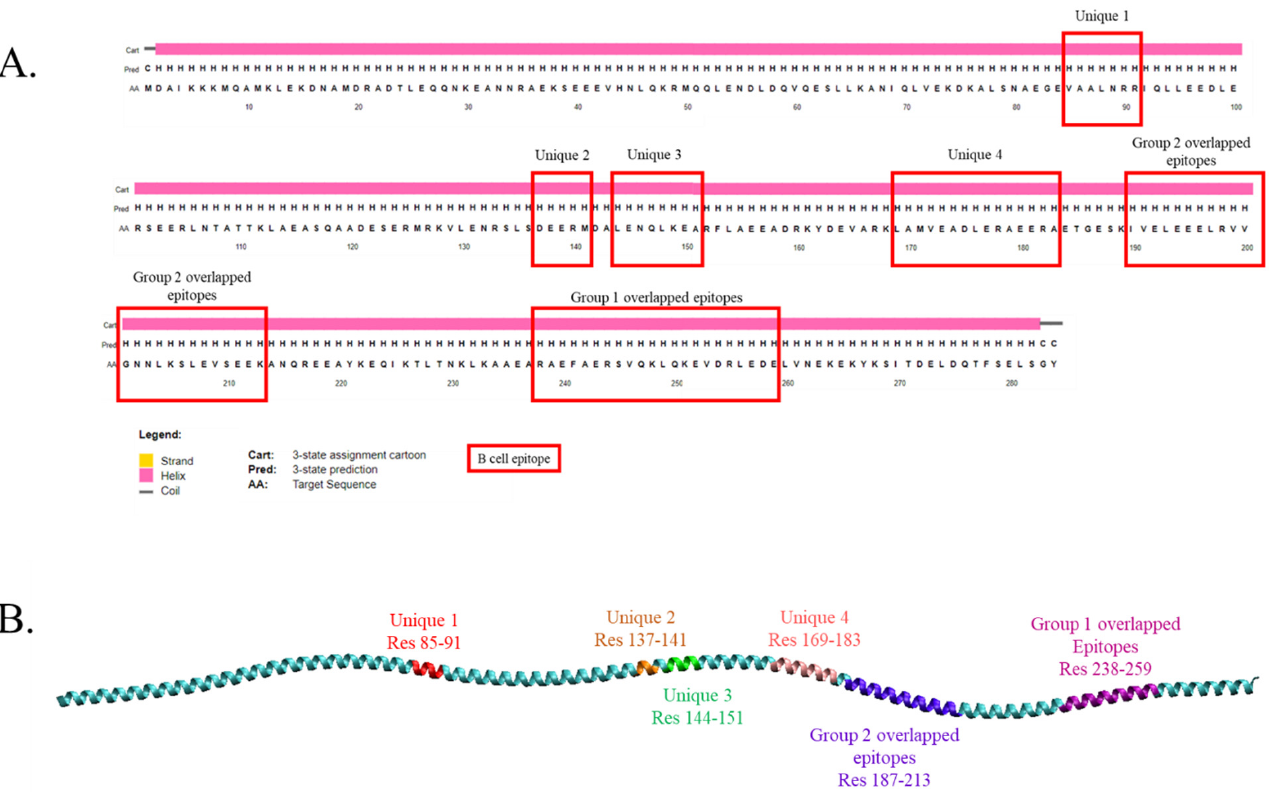
Figure 2. Consensus linear B cell epitope identified by AlgPRED and BepiPRED web tools. ( A ) Sequence with the predicted secondary structure of black tiger shrimp tropomyosin. The predicted consensus amino acids responsible for cross-reactive allergy were indicated in the red square. ( B ) The location of each type of identified linear B cell epitopes illustrated in 3D structure of black tiger shrimp tropomyosin derived from AlphaFold database.